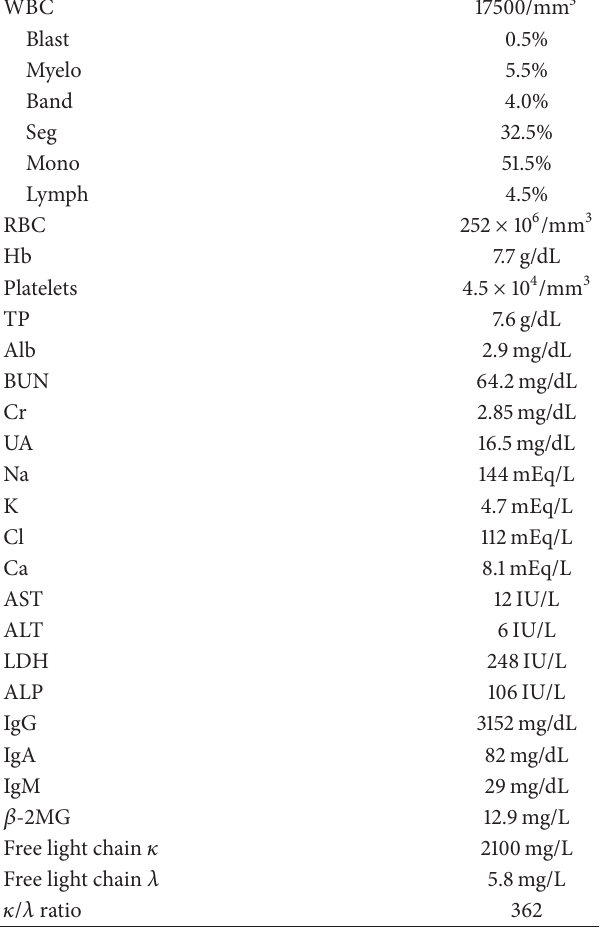
Table 3: Laboratory data on second